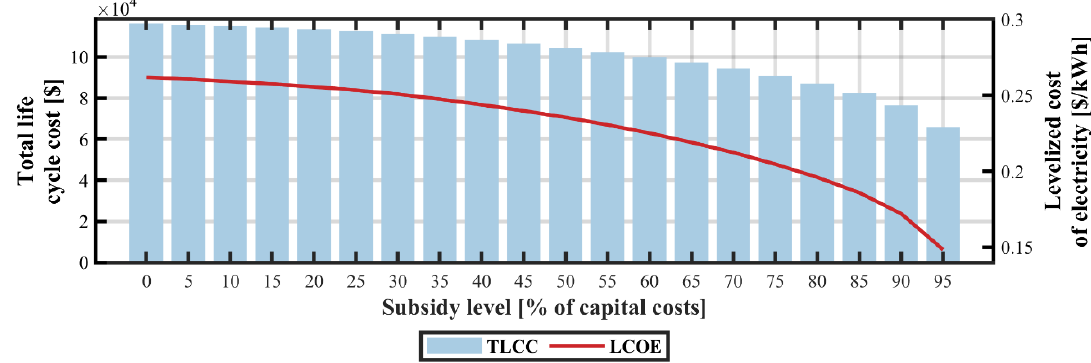
Figure 15. Simulation results of capital subsidies for wind technologies. Impact on LCOE and TLCC.